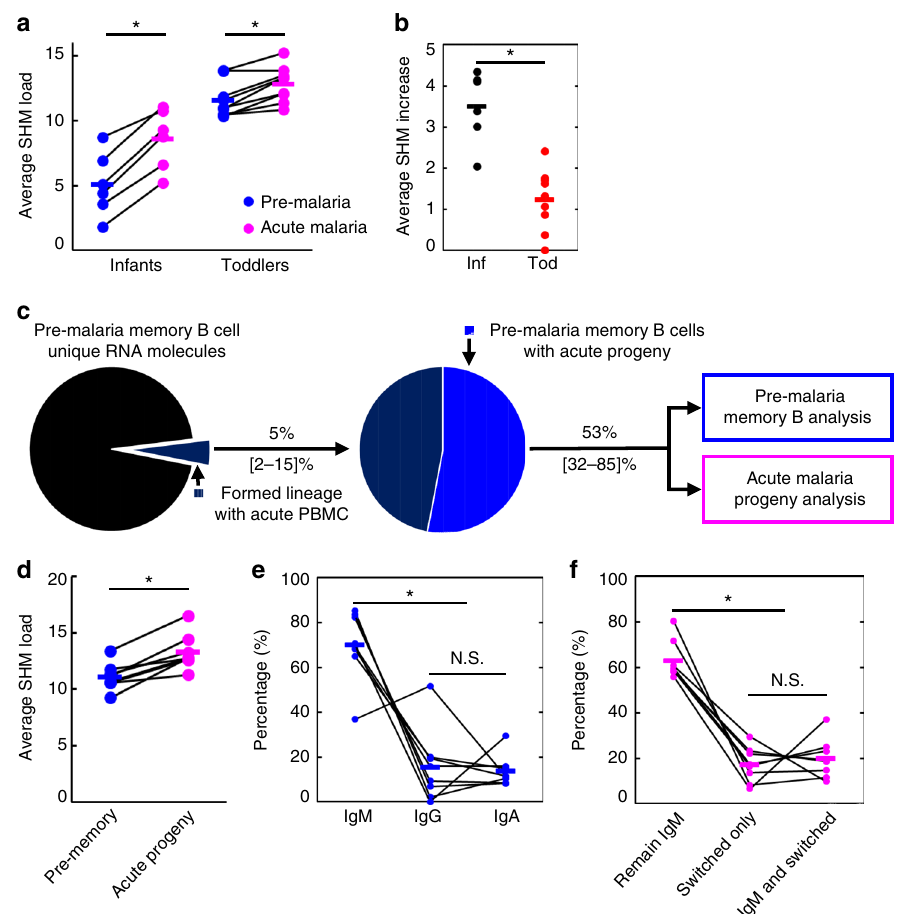
Fig. 6 Two time point-shared lineage analysis reveals SHM increment during acute malaria infection. a Average SHM for sequences from pre-malaria ( blue ) and acute malaria ( pink ) time points within lineages containing sequences from both time points for infants ( N = 6) and toddlers ( N = 9). b Average SHM increase upon acute malaria infection for infants ( black ) and toddlers ( red ) from ( a ). c Flow diagram for two time point-shared lineage containing pre- malaria memory B cell identi fi cation and acute progeny analysis. Percentages represent the average percent of unique sequences classi fi ed by the indicated slice, range in brackets . d Average SHM load for pre-malaria memory B cells with acute progeny ( blue ) and their acute progenies ( pink ) for malaria- experienced toddlers with FACS-sorted pre-malaria memory B cells ( N = 8). e Isotype distribution of pre-malaria memory B cells with acute progeny. f Isotype fate of acute progenies stemming from IgM pre-malaria memory B cells. Lines connect the same individuals. Bars indicate means. a , d – f * P < 0.05, N.S. indicates not signi fi cant by two-tailed Wilcoxon signed-rank test. b * P < 0.05 by two-tailed Mann – Whitney U